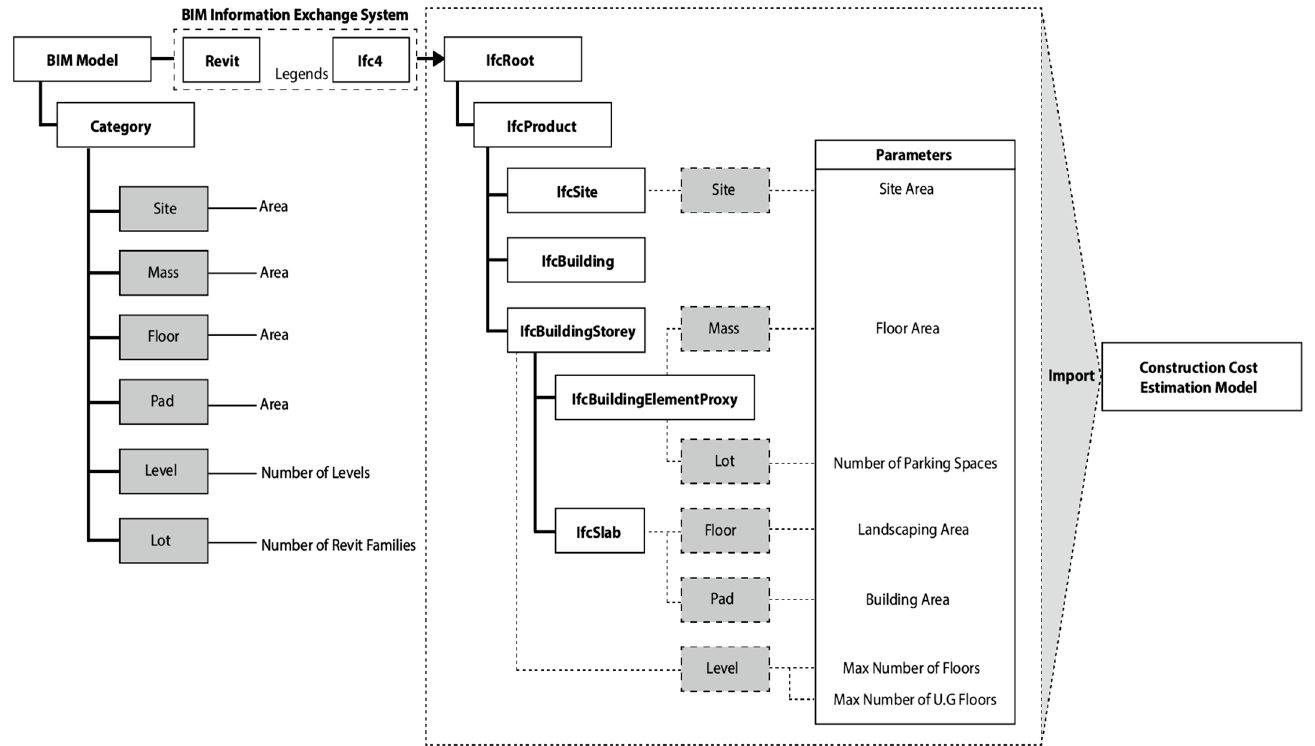
Figure 10. IFC schema and parameters. Table 6. Prediction results using the BIM setups for 10 datasets.